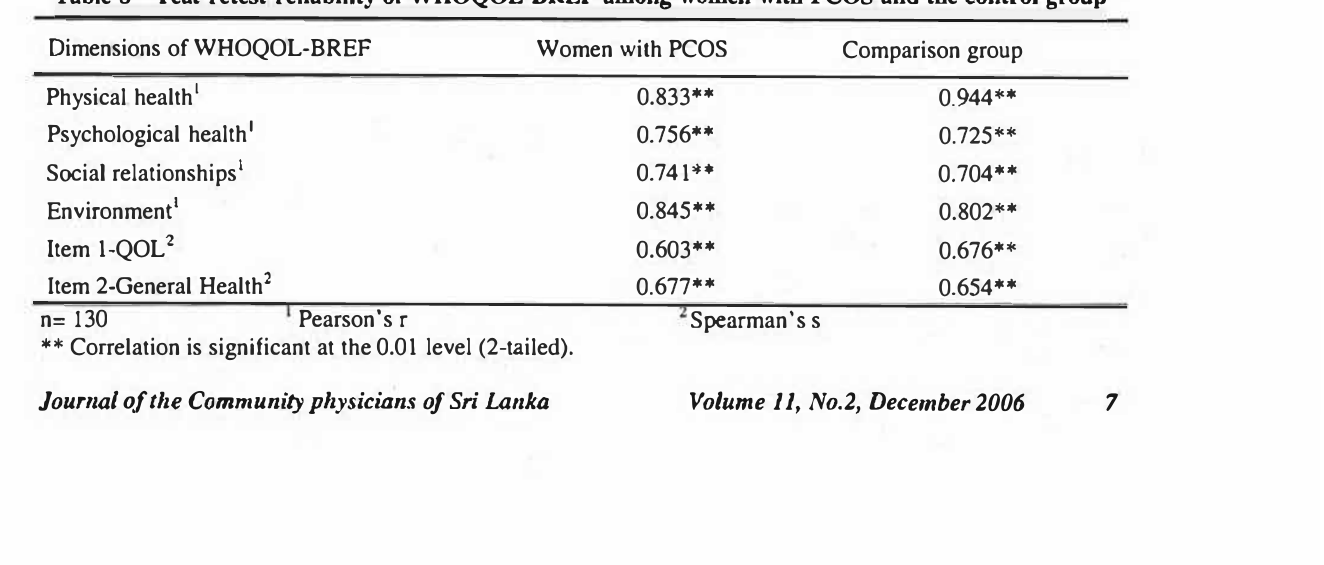
Table 8 -Teat-retest reliability of WHOQOL-BREF among women with PCOS and the control group Dimensions